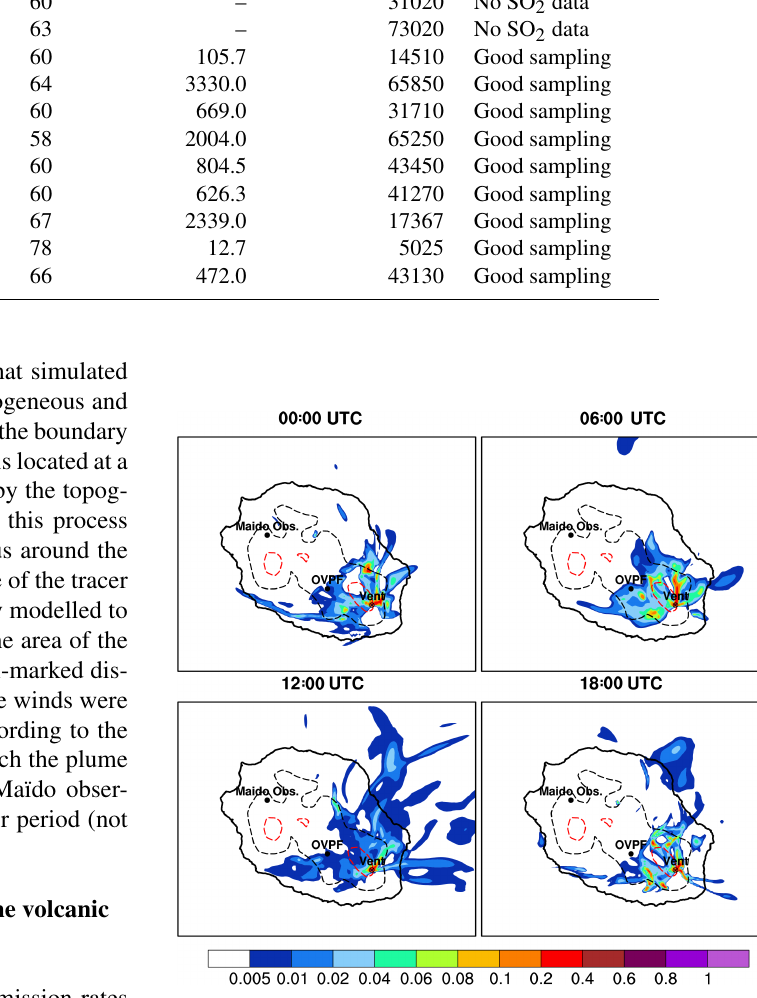
Figure 3. Normalised hourly temporal mean of a tracer (represent- ing the SO 2 ) load integrated over all model levels emitted at the vent and simulated by FLEXPART between 17 May at 00:00UTC and 31 May at 23:00UTC. The locations of the Maïdo observa- tory, the OVPF and the vent are indicated on the figure. The dotted lines show the 1000ma.s.l. (black) and 2000ma.s.l. (red) topogra- phy level